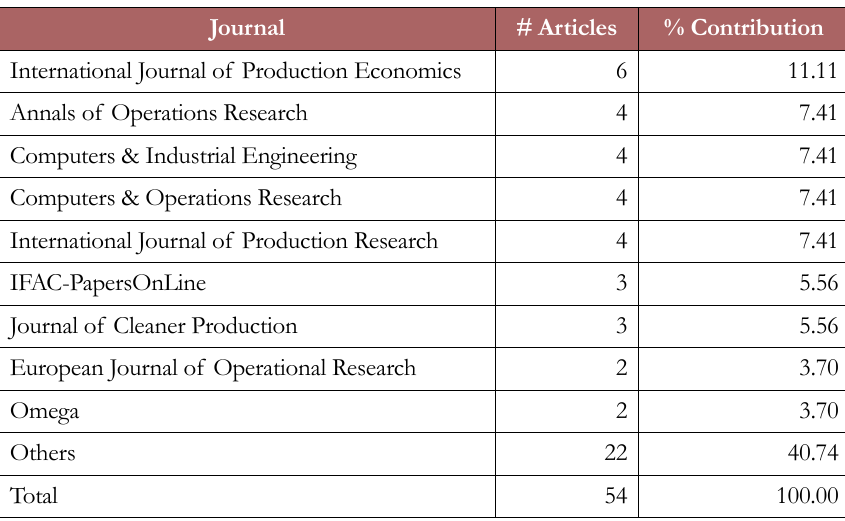
Table 5. Distribution of the 54 selected papers across the